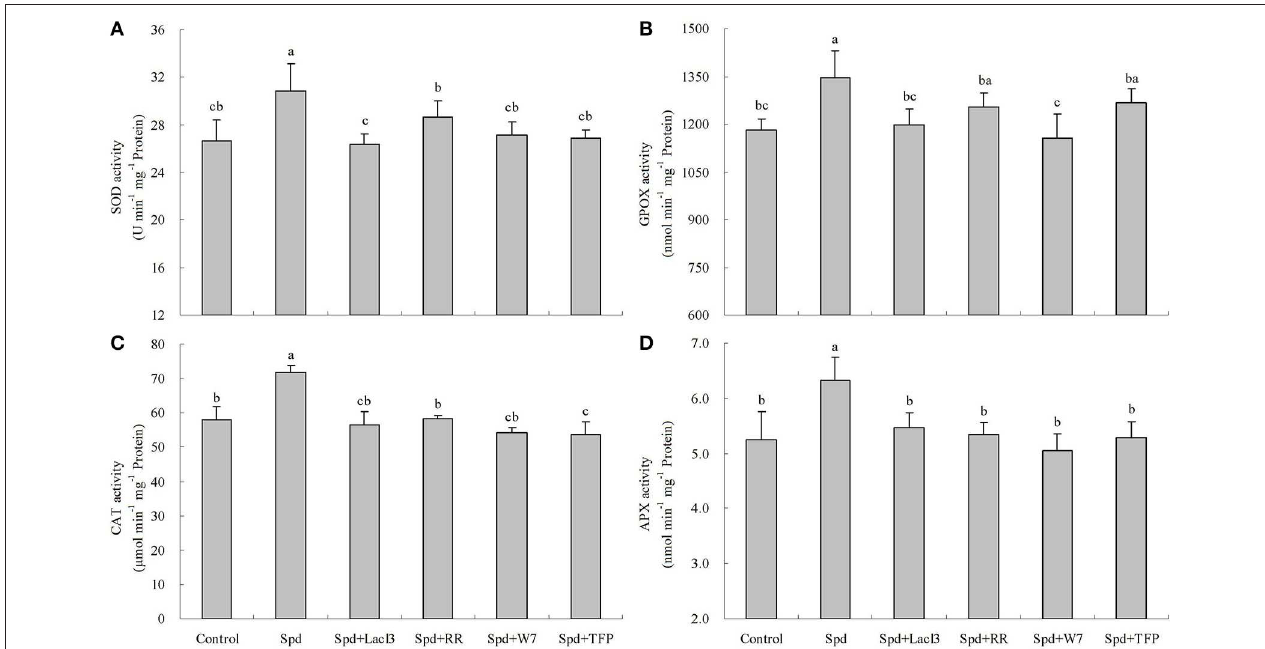
FIGURE 11 | Spd-induced SOD (A), GPOX (B), CAT (C), and APX (D) activities were dependent on calcium (Ca 2 + ) messenger system. The detached leaves of white clover were pre-treated with distilled water for 1h to eliminate wound stress and then treated for 8h as follows: 1, distilled water (control); 2, 20 µ M Spd; 3, 20 µ M Spd + 1mM LaCl 3 ; 4, 20 µ M Spd + 50 µ M ruthenium red (RR); 5, 20 µ M Spd + 150 µ M N-(6-Aminohexyl)-5-chloro-1- naphthalenesulfonamide (W7); 6, 20 µ M Spd + 30 µ M trifluoperazine (TFP). Means of six independent samples are presented. Bars represent standard errors. The same letter indicates no significant difference (LSD) at P <